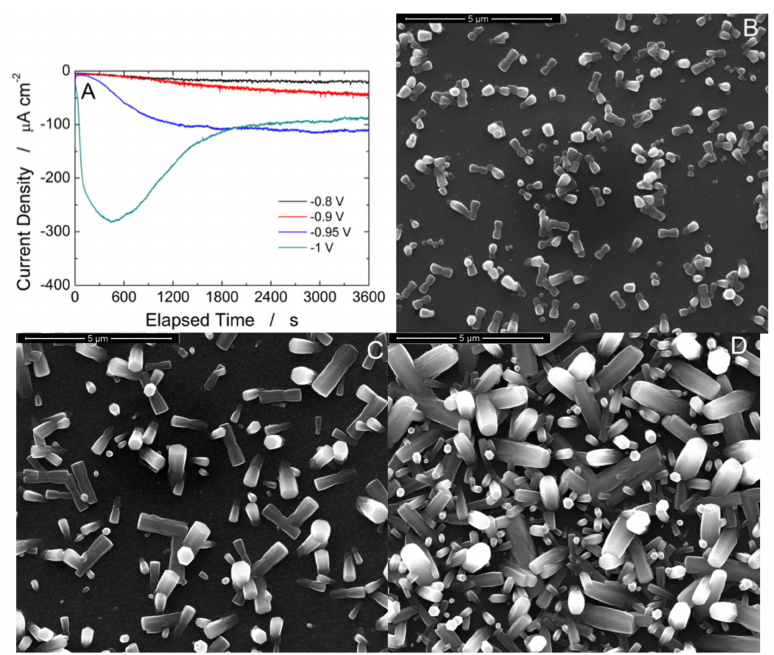
Figure 5. ( A ) Current density curves and SEM images ( B ) − 0.8 V, ( C ) − 0.9 V, and ( D ) − 0.95 V vs. Ag/AgCl) of electrodes obtained using a de-aerated solution of 10 mM ZnCl 2 and 10 mM NaNO 3 at pH 4.5 for 60 min at 60 ◦ C.